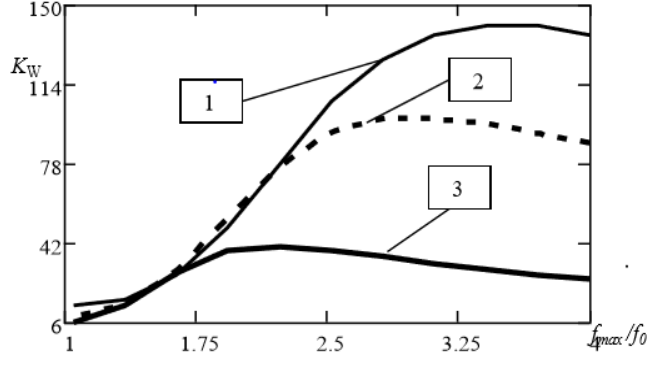
Fig. 1. The dependence of the factor K W on the low-frequency boundary.